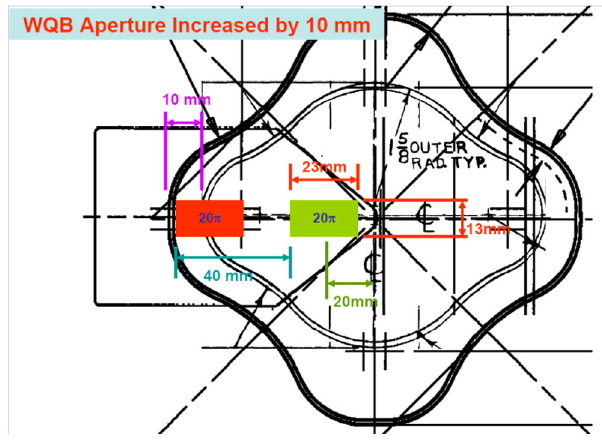
FIG. 9. Aperture improvement using WQB large aperture FIG. 10. Residual radiation on contact with top of beam pipe at quadrupoles are shown in this end view of the vacuum pipes locations between an upstream dipole and defocusing quadru- (old and new) and the Lambertson that is downstream. pole after cool down of a few hours. Data taken on June 11, ffiffiffiffiffiffiffiffi p 7 = 4 ¼ 1 : 32 , improved